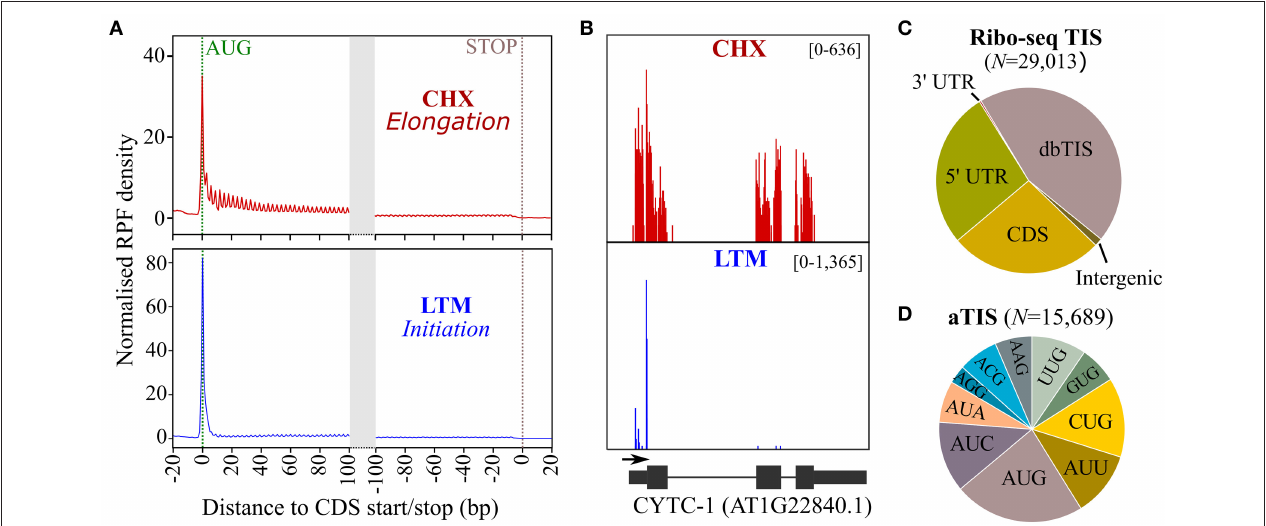
FIGURE 1 | Ribosome sequencing (Ribo-seq) translation initiation site (TIS) calling in Arabidopsis thaliana . (A) Normalized ribosome footprint (RPF) density in TAIR10 Arabidopsis annotated coding sequence (CDS, representative gene model) regions after treatment with cycloheximide (CHX, red), which halts translation elongation, and lactimidomycin (LTM, blue), which halts translation initiation. (B) CHX (red) and LTM (blue) read coverage for cytochrome C-1 (AT1G22840.1). (C) Location of TIS called by PROTEOFORMER with respect to annotated TAIR10 gene models (for overview, see Supplementary Dataset S1 ). (D) Start codon distribution for called alternative TIS